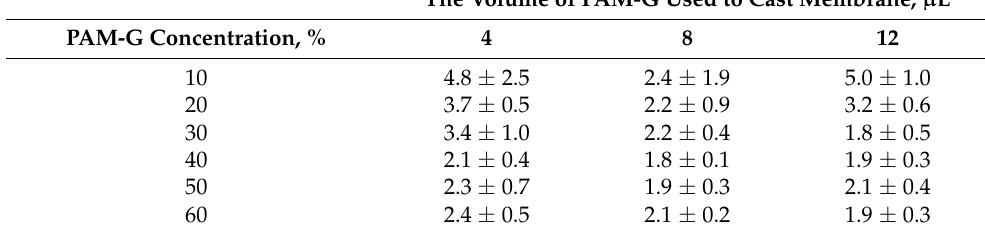
Table 1. Percentile fraction of diffused Cl − through the membranes of various sizes and concentra- tions after 20 h. The results are shown with standard deviation, n = 6.